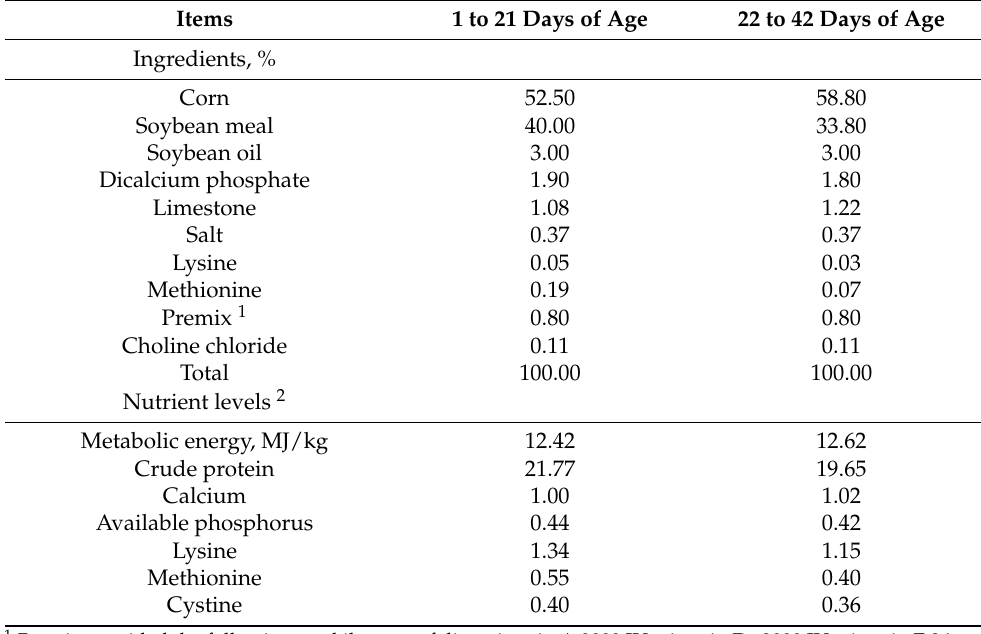
Table 1. Composition and nutrient levels of the basal diet (as-fed basis). Items 1 to 21 Days of